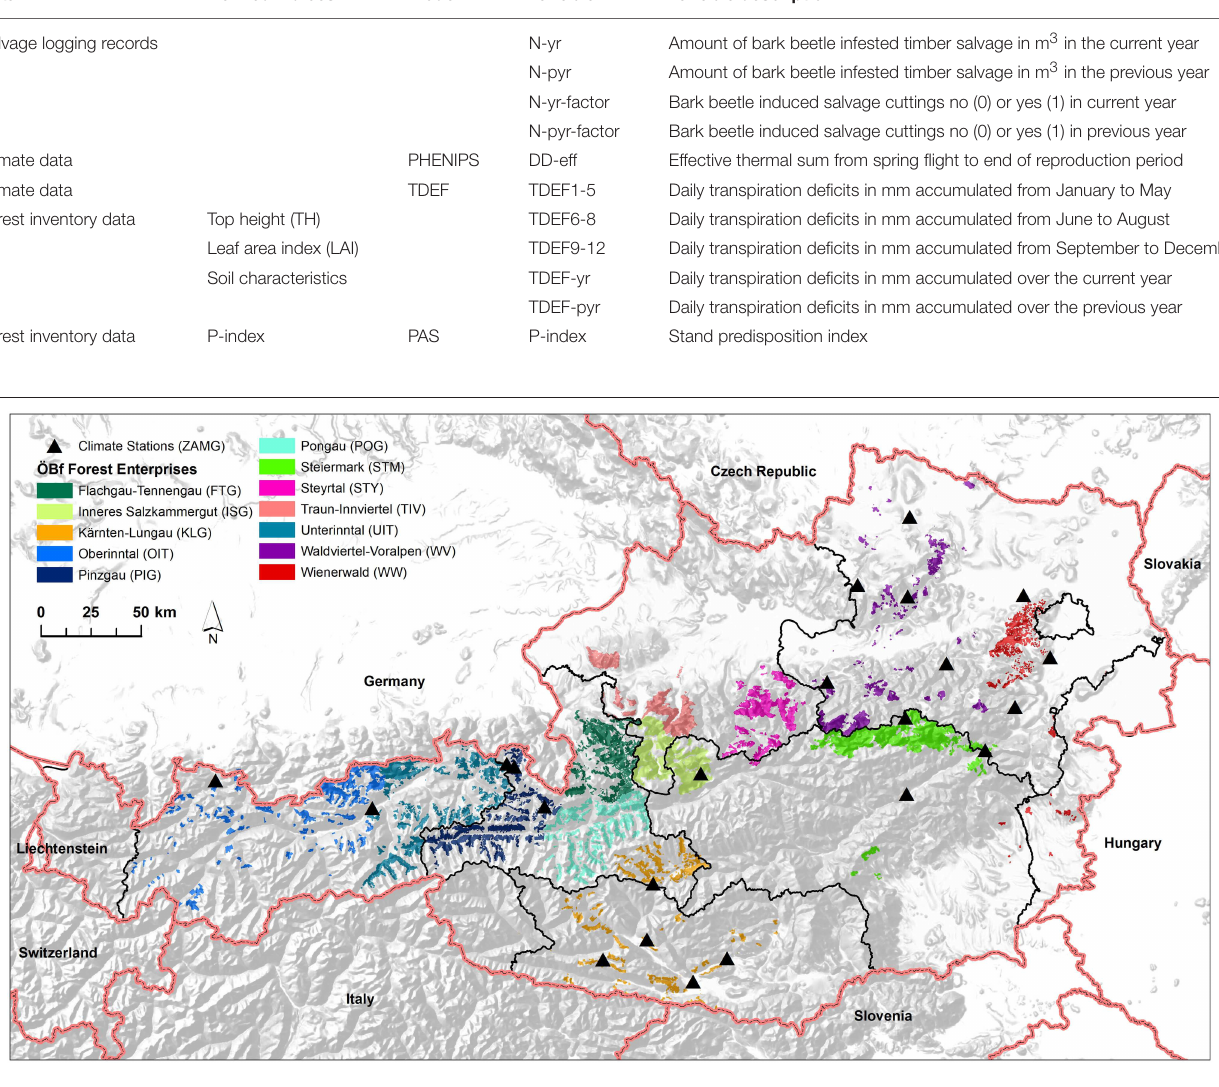
FIGURE 1 | Map showing the geographical distribution of Austrian Federal Forests (ÖBf) forest enterprises (12) and weather stations of the Austrian institution for meteorology and geodynamics (ZAMG)